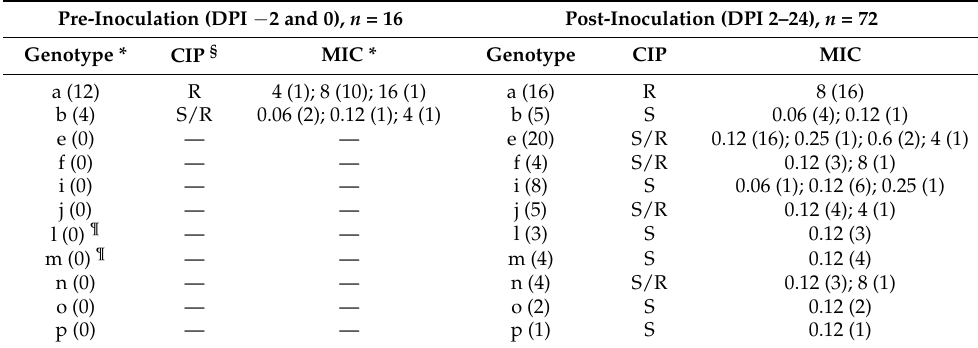
Table 3. PFGE genotypes and ciprofloxacin susceptibility of C. jejuni isolates from calves in Group 1 obtained throughout the study #